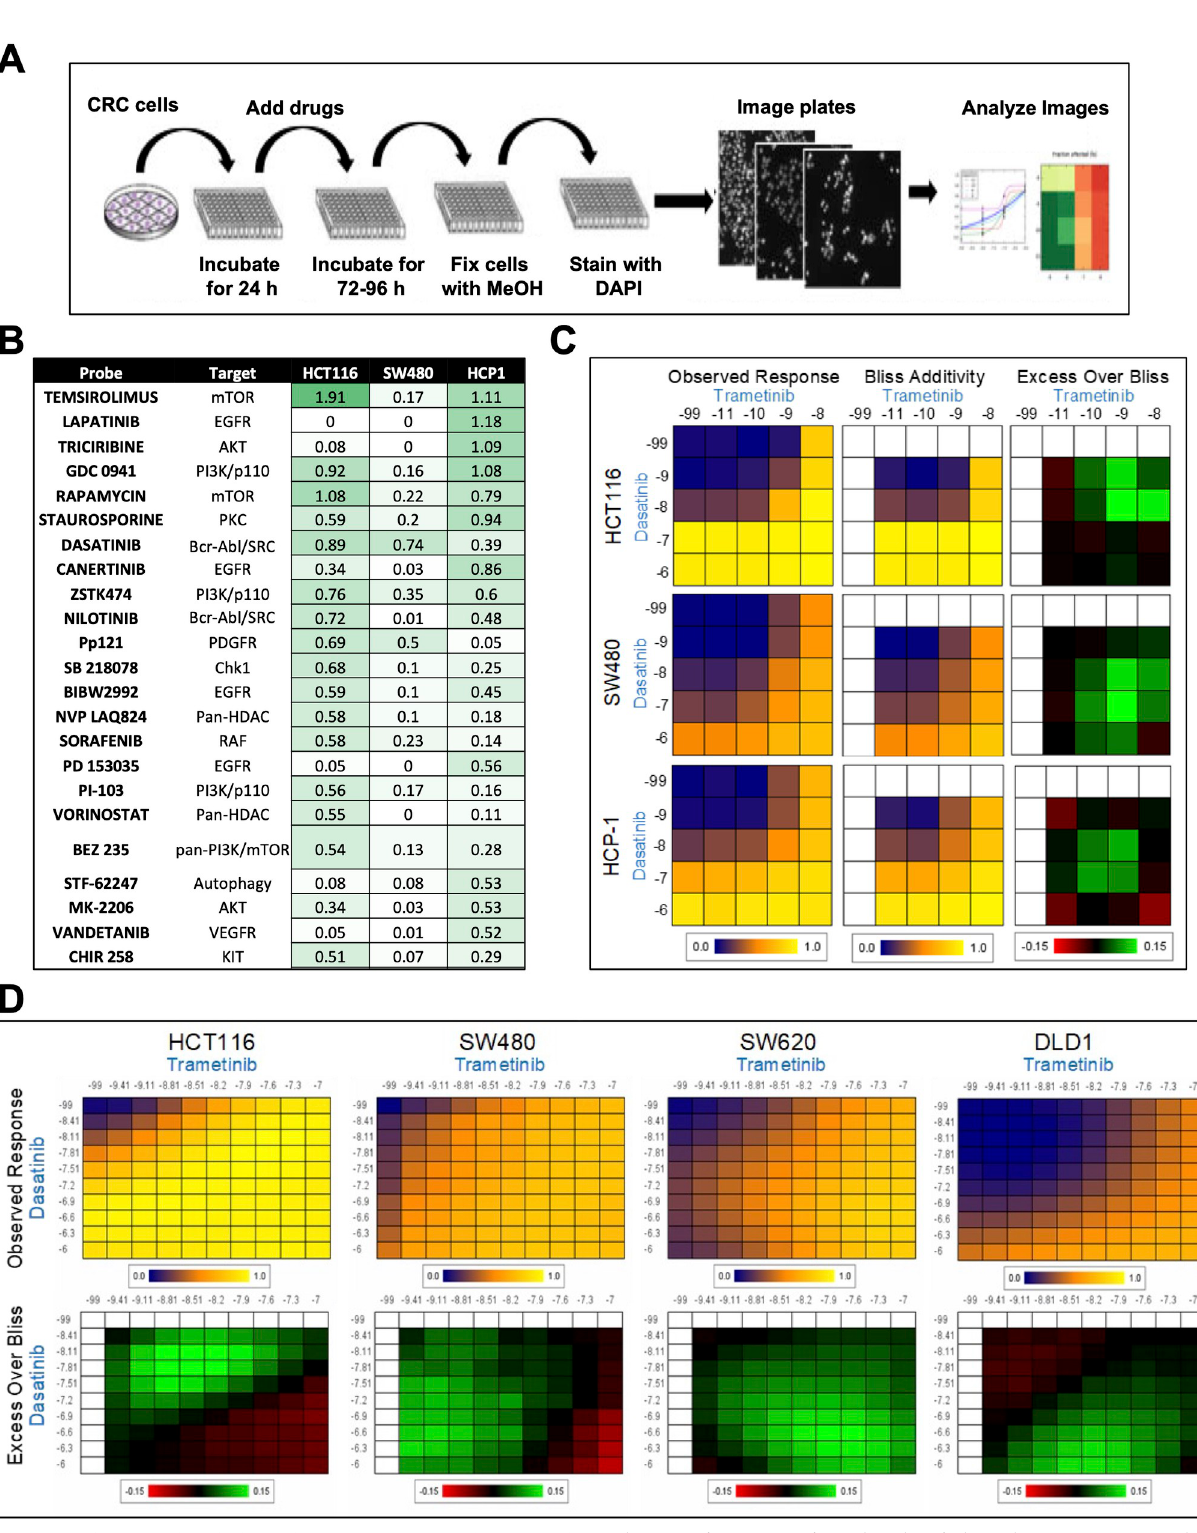
PLOS ONE | https://doi.org/10.1371/journal.pone.0281063 March 23,